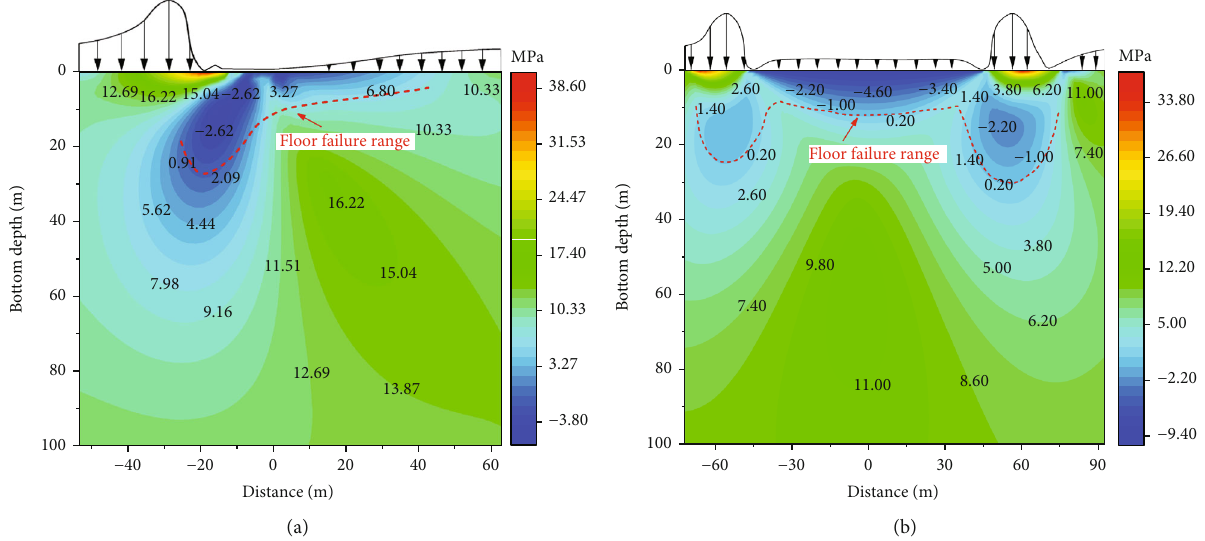
Figure 13: Theoretical calculation results of fl oor failure range after RHF: (a) along the inclination; and (b) along the